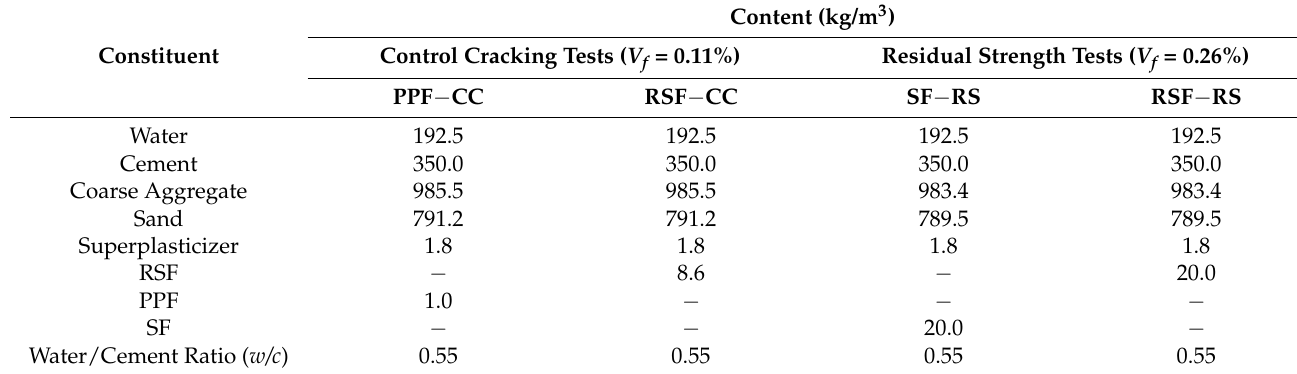
Table 2. Concrete mixes used in this